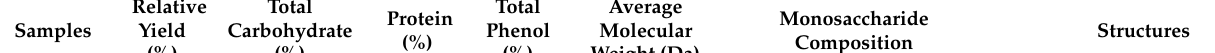
Table 1. Physicochemical property of Zizyphus jujuba cv. Muzao